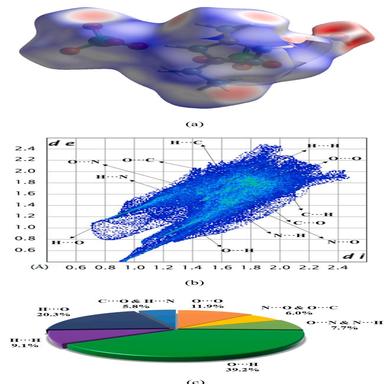
(a) Visualization of Hirshfeld surfaces for 2. (b) 2D fingerprint plots. (c) Evaluation of the percentage contribution of individual atomic contacts.